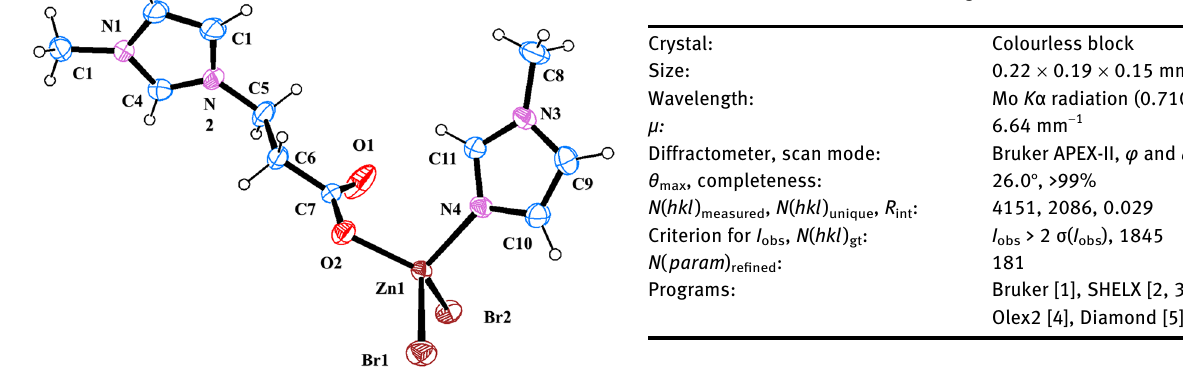
Table  : Data collection and